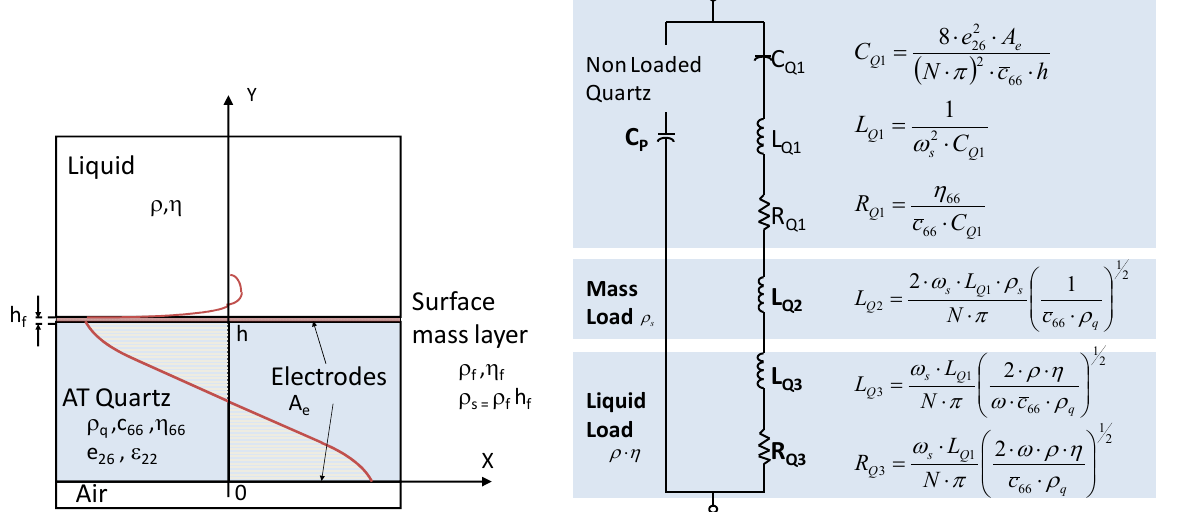
Figure 1. Electromechanical model of a piezoelectric resonator for microgravimetrical applications in liquid; Cross-section of a loaded resonator and BVD equivalent circuit modified by Martin and